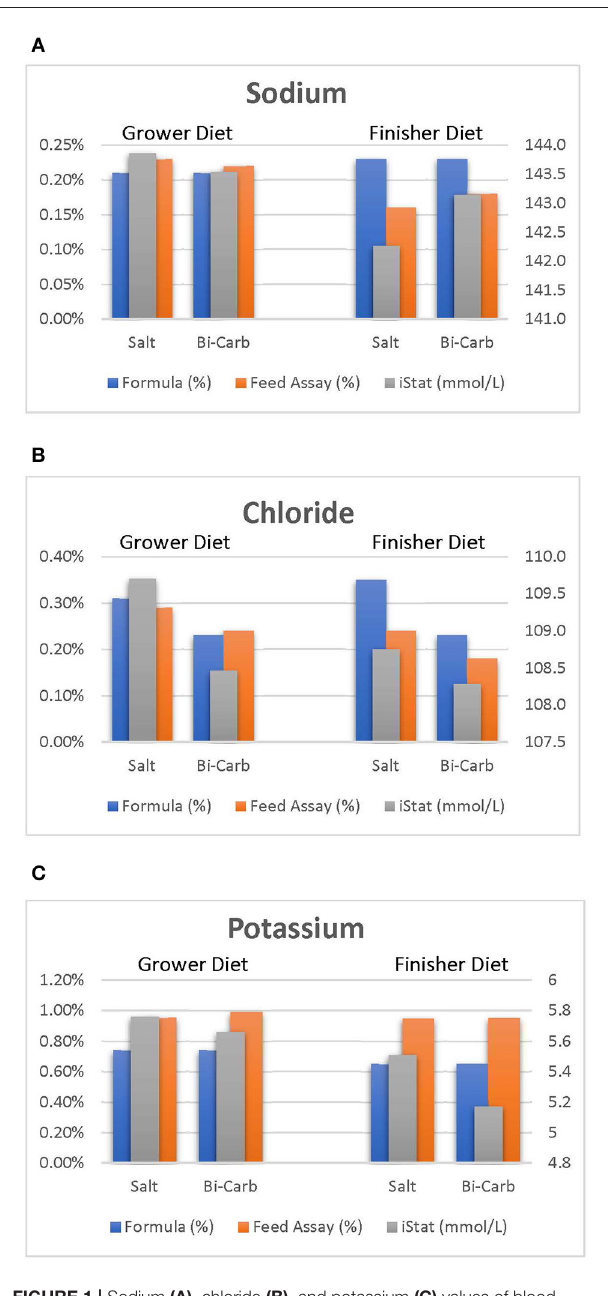
A negative impact of unbalanced dietary electrolyte levels and a transient negative influence of heat stress was noted in broilers chickens fed traditional corn/soy diets, with confirmation of stress noted in mortality percentage and postmortem